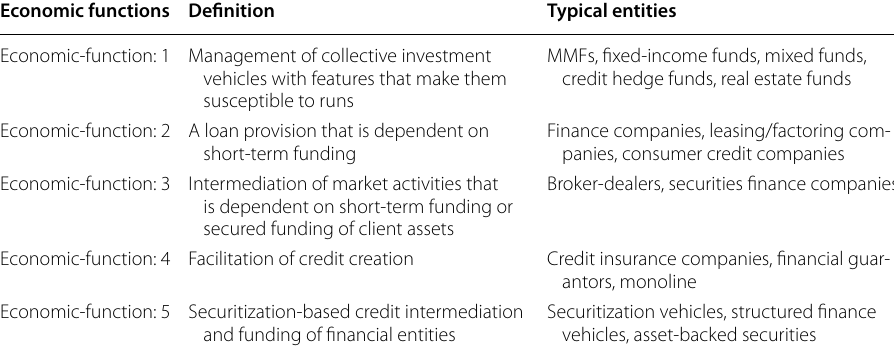
Table 1 FSB’s narrow definition of shadow banking and example of classified entity